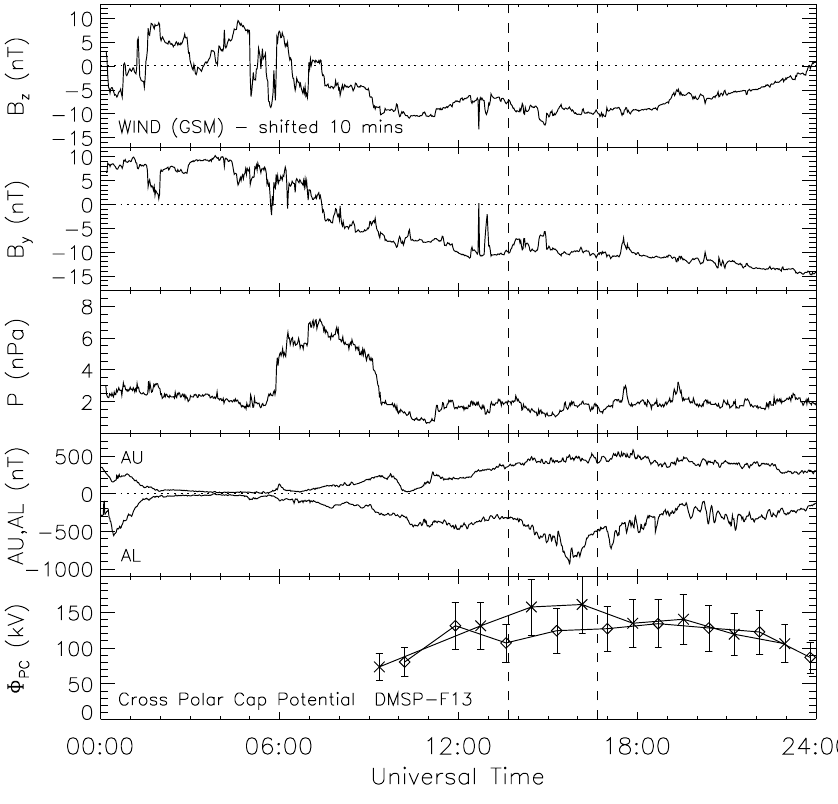
Fig. 2. Data presenting an overview of solar wind and magnetospheric varia- tions on 20 August 1998. The panels show the interplanetary magnetic field B z and B y components (in GSM co- ordinates) and solar wind dynamic pres- sure from the WIND spacecraft, the AU and AL index variations, and the cross-polar cap potential estimate from